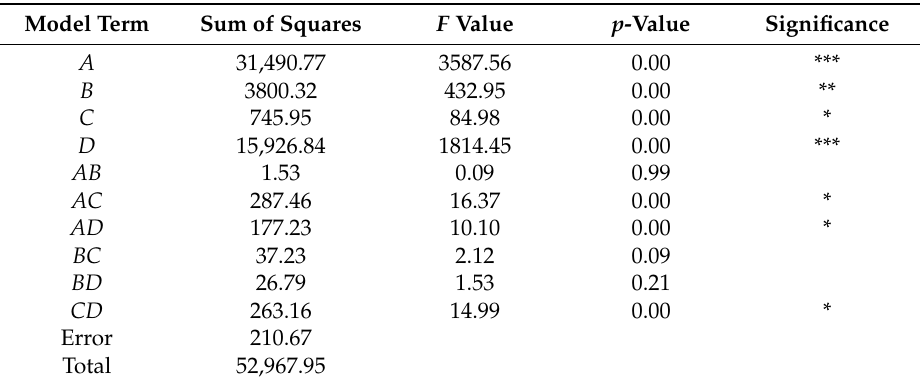
Table 5. Results of ANOVA for the flood period runoff simulation.